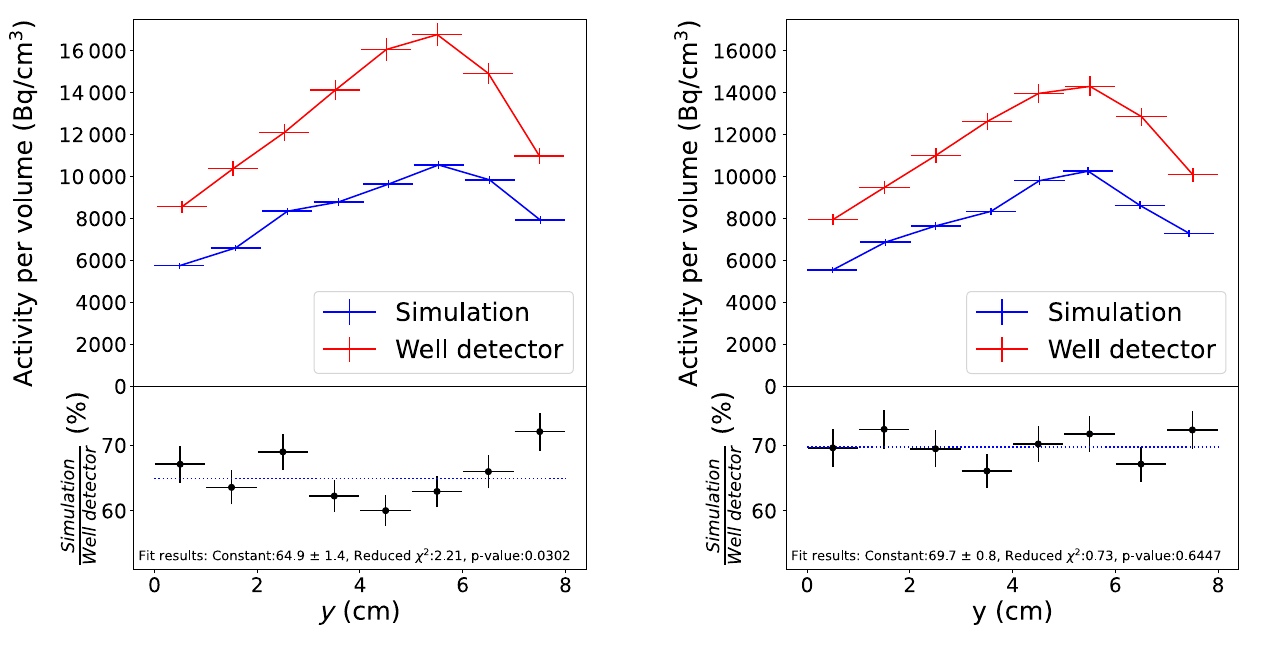
FIG. 14. Comparison of activity measurements and FLUKA simulations for Rod 6. Refer to the caption of Fig. 12 for details related to the